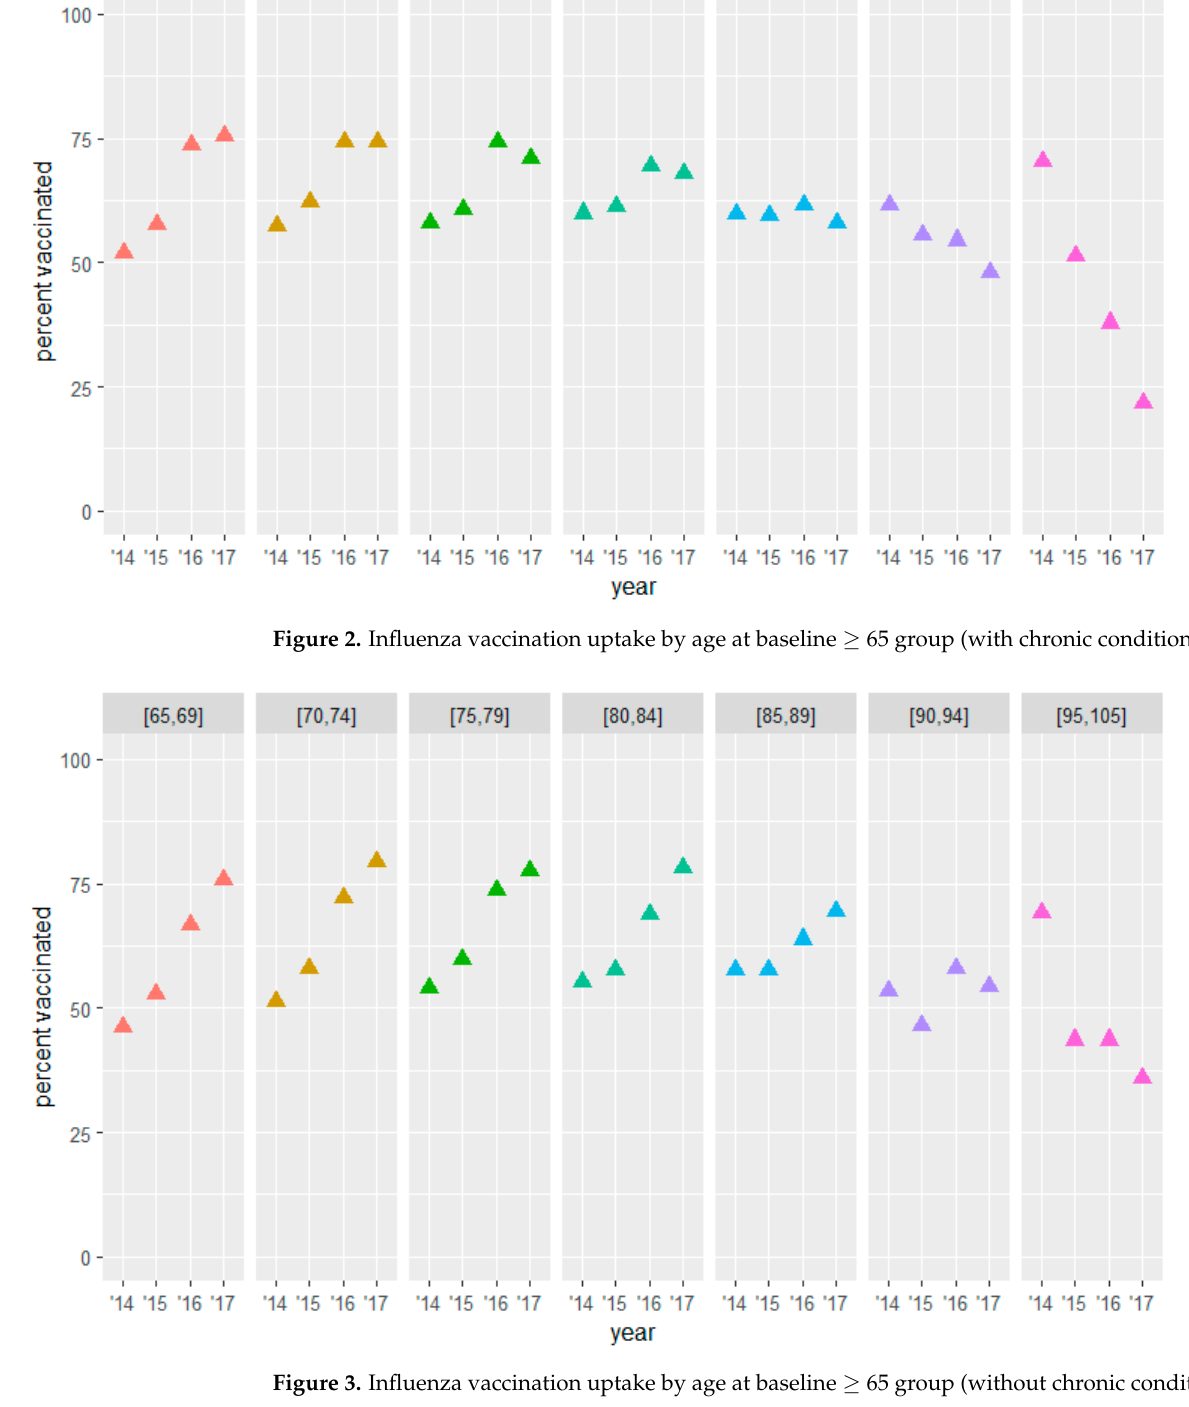
Table 7. Influenza vaccination uptake by age at baseline < 65 group (with chronic condition).